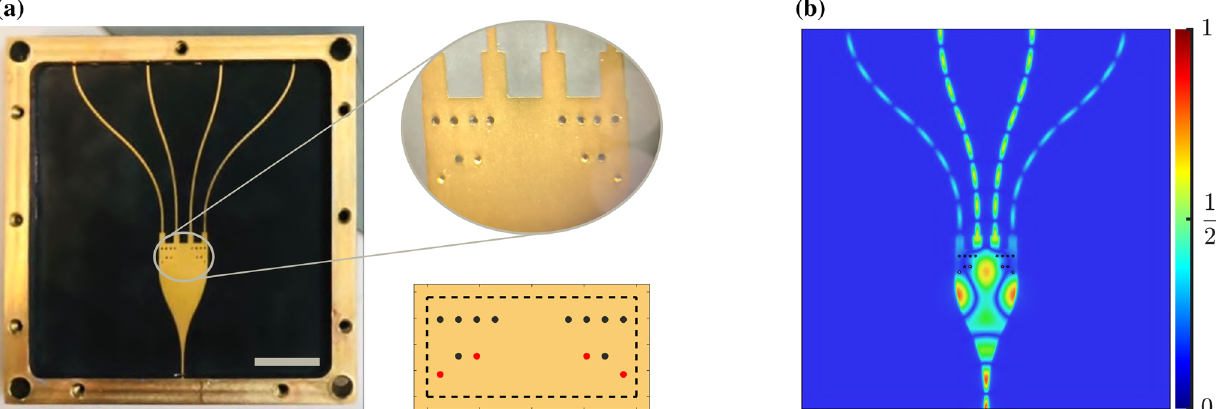
Figure 8. ( a ) Photograph of the fabricated power splitter embedded in a metal box. The gray bar in the photo corner corresponds to the length of 10 mm. A close-up view of the vias pattern, together with its schematical view, is shown. Black and red circles indicate lossy dielectric and metalized vias, respectively. ( b ) Normalized electric field distribution carried out by full-wave simulations.